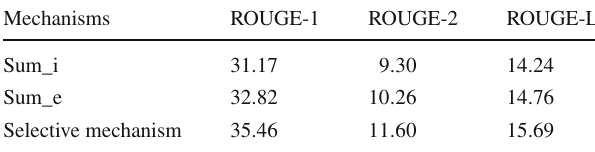
Table 2 Results of different fusion mechanism on the test set